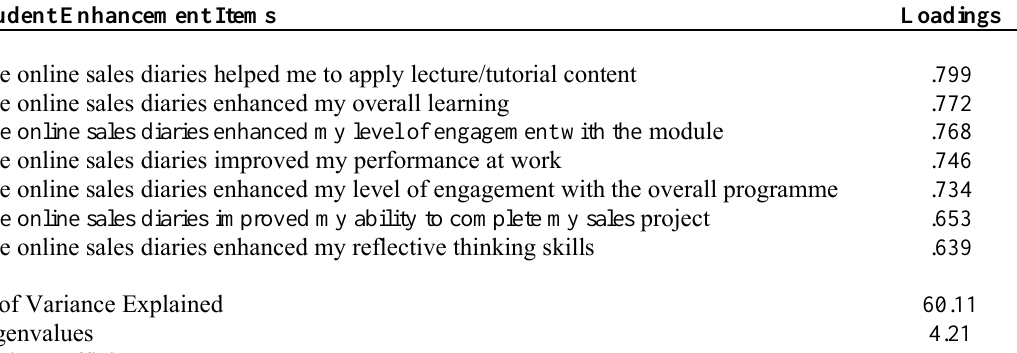
Table 4: Factor structure of student